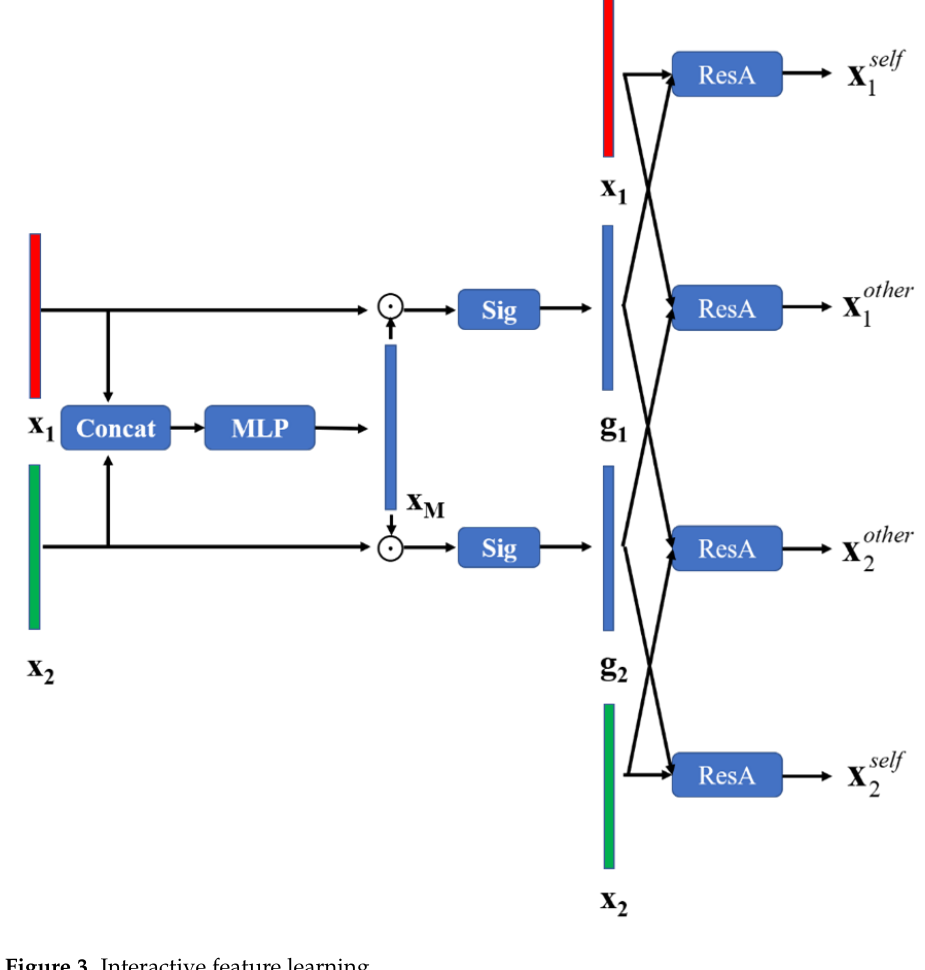
Figure 3. Interactive feature